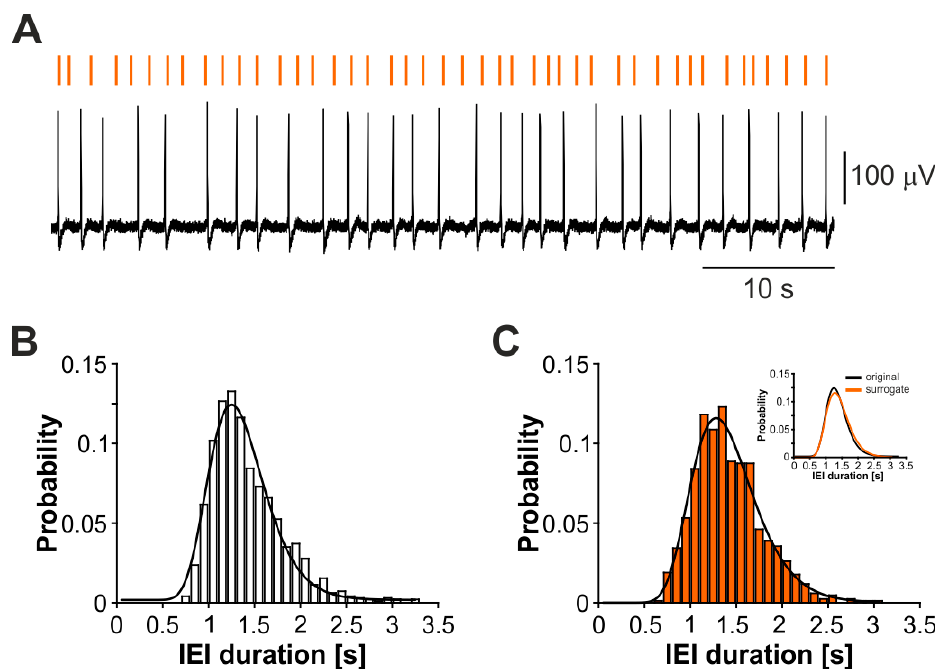
Figure 3. Surrogate lognormal pulse trains mimic the temporal dynamics of the CA3-driven inter- ictal pattern. ( A ) Representative 60 s segment of the CA3-driven interictal activity (black) and the obtained surrogate pattern (orange bars). The probability distributions of the original ( B ) and surrogate ( C ) data, fit by a lognormal (solid lines), are statistically similar, as also emphasized by the overlapped fitted curves in the insert of panel ( C ).